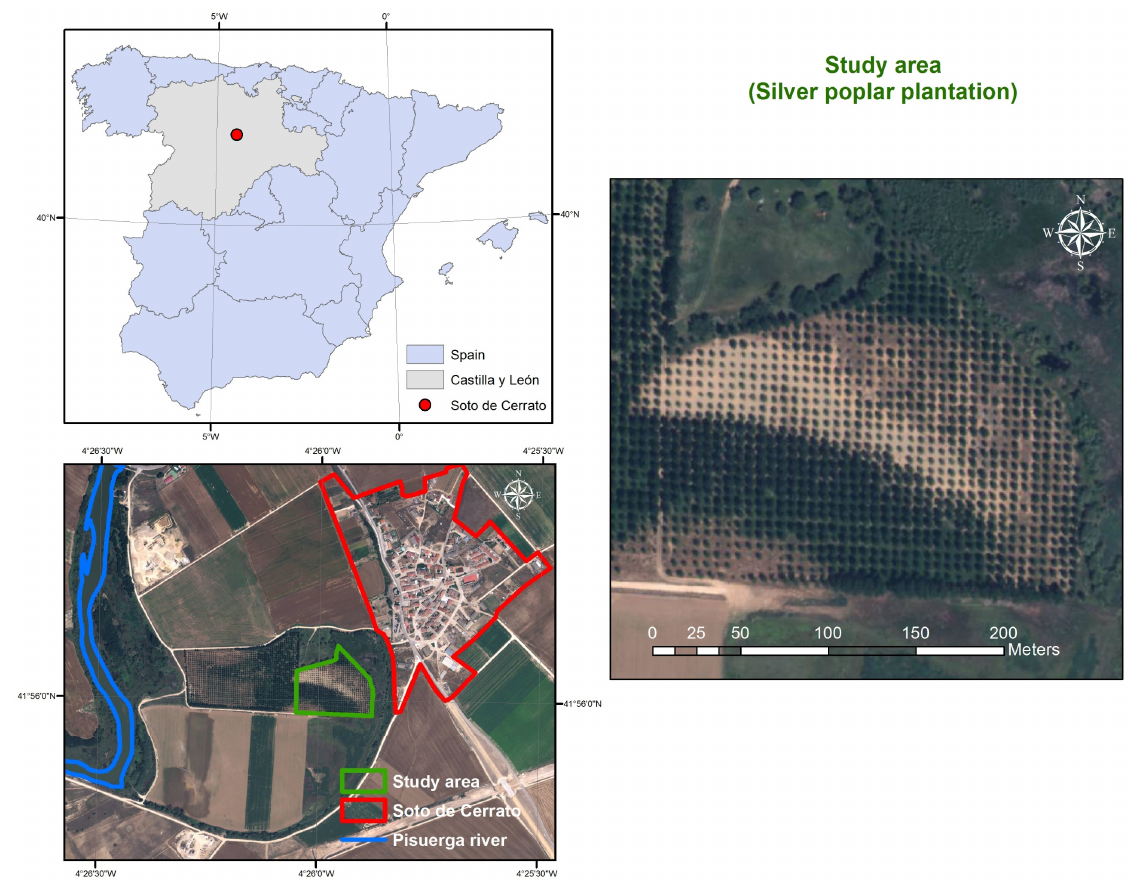
Figure 1. Top left: study area location in Spain. Lower left: study area location in the region of Soto de Cerrato, Palencia. Right: the plot area.